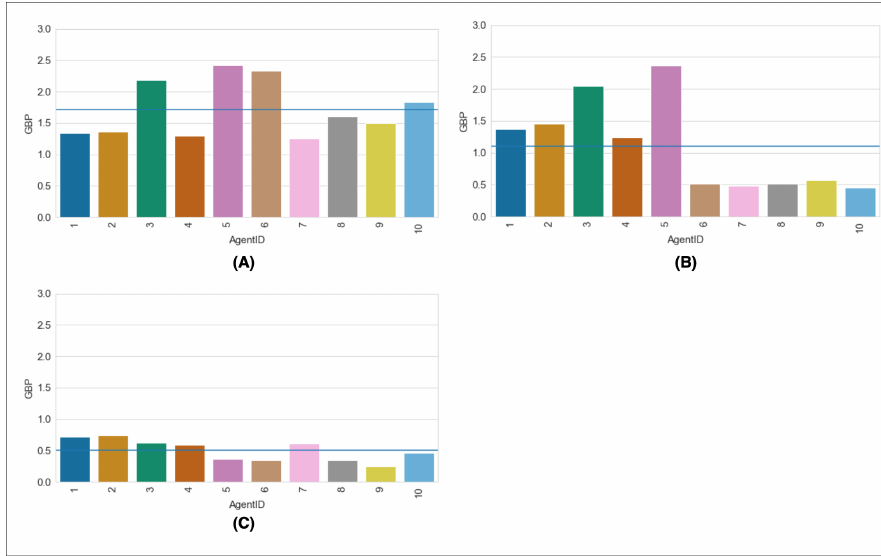
Figure 9. The total sum of electric costs (GBP) for each PHEV, model conditions 1 to 3. Where ( A ):